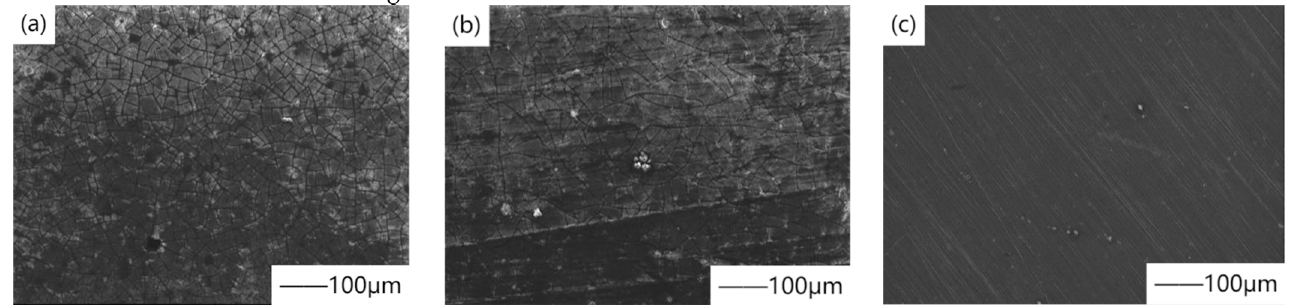
Figure 3. SEM surface morphology of the magnesium fluoride-coated materials after 11 days of immersion in DMEM: ( a ) PM Mg, ( b ) cast Mg, and ( c ) AZ31 alloy. Reprinted with permission from Ref. [27]. Copyright 2011 Copyright Elsevier.